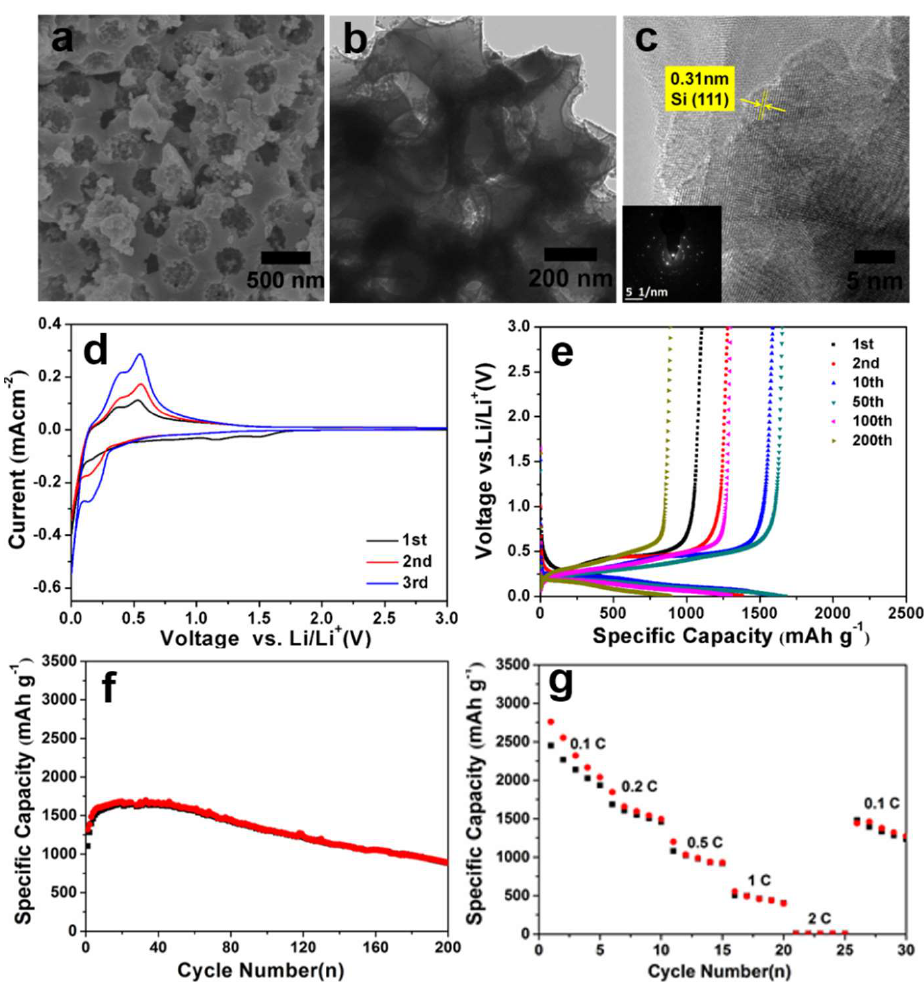
Figure 3. SEM ( a ), TEM ( b ), and HRTEM ( c ) images and SAED pattern (inset of image ( c ); cyclic voltammetry curves ( d ) (scanning rate: 0.2 mV s − 1 ); galvanostatic discharge/charge profiles ( e ) of the 900-HCl sample; cycling performance ( f ) (current density: 0.2 C); and rate performance ( g ) of 900-HCl and 900-HF samples ( f , g